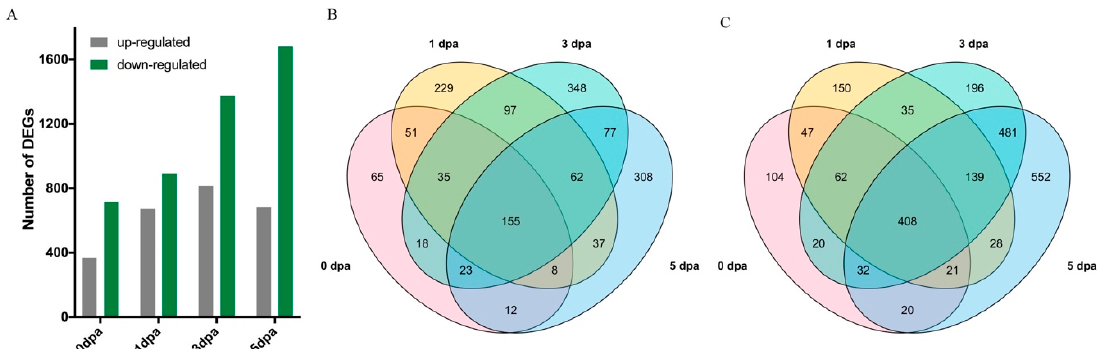
Figure 6. Transcriptome analysis of the lintless accession. ( A ) Number of differentially expressed genes (DEGs) identified in pairwise comparisons between lintless accession A2_106 (LL) and normal fuzzy-linted accession BM13H (Normal) ovules. ( B ) Venn diagram showing upregulated DEGs in LL relative to Normal at each of the four timepoints. ( C ) Venn diagram showing down-regulated DEGs in LL relative to Normal. Numbers of overlapping genes between timepoints are indicated.